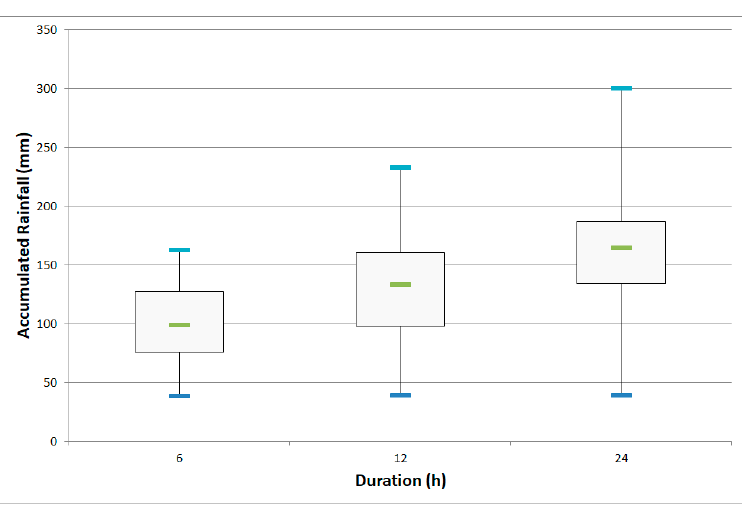
Figure 6. Box plot of accumulated rainfall used in this study.